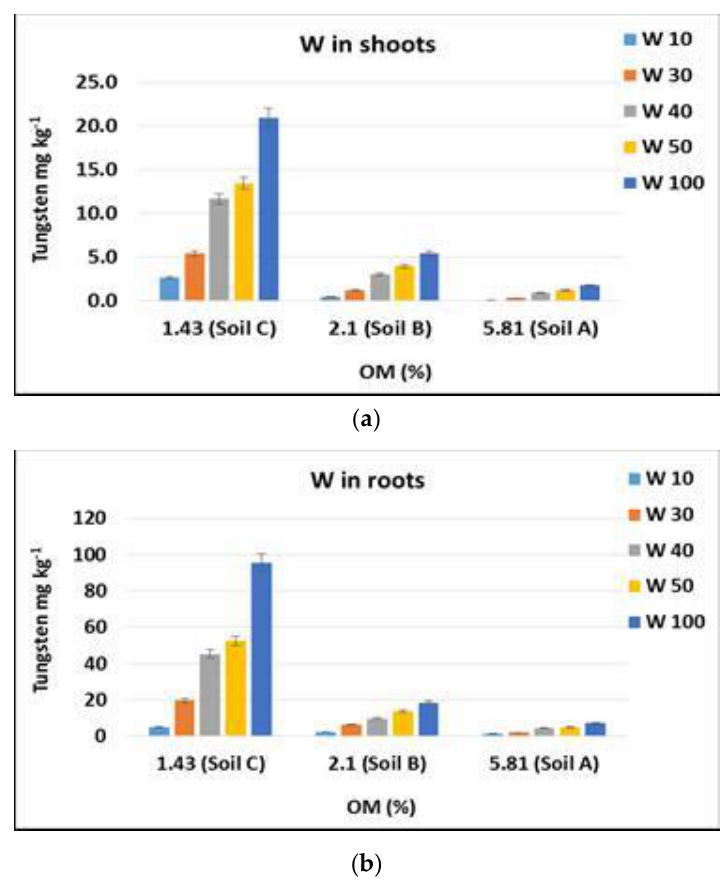
Figure 3. Mean values of tungsten concentrations in plants in relation to organic matter (OM%) of the different soils. Bars indicate standard deviation. ( a ) shoots; ( b ) roots.